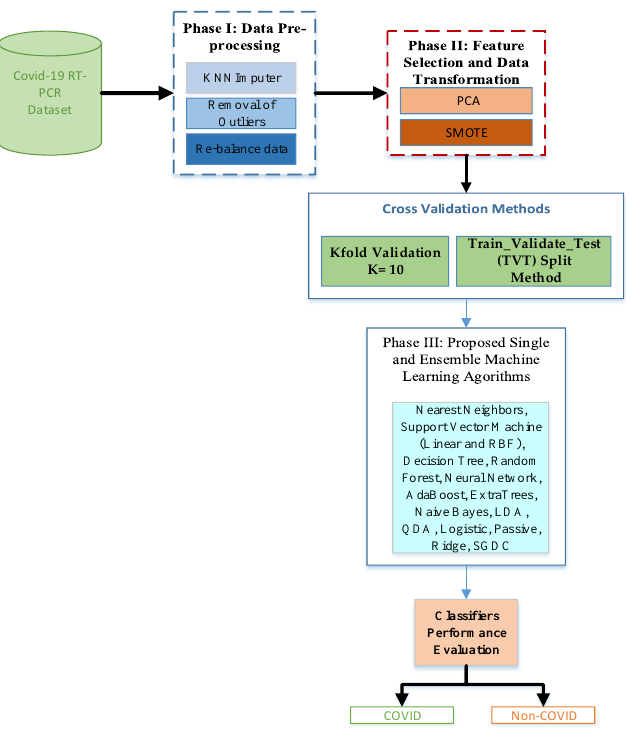
Figure 1. Visual summary of the proposed methodology.